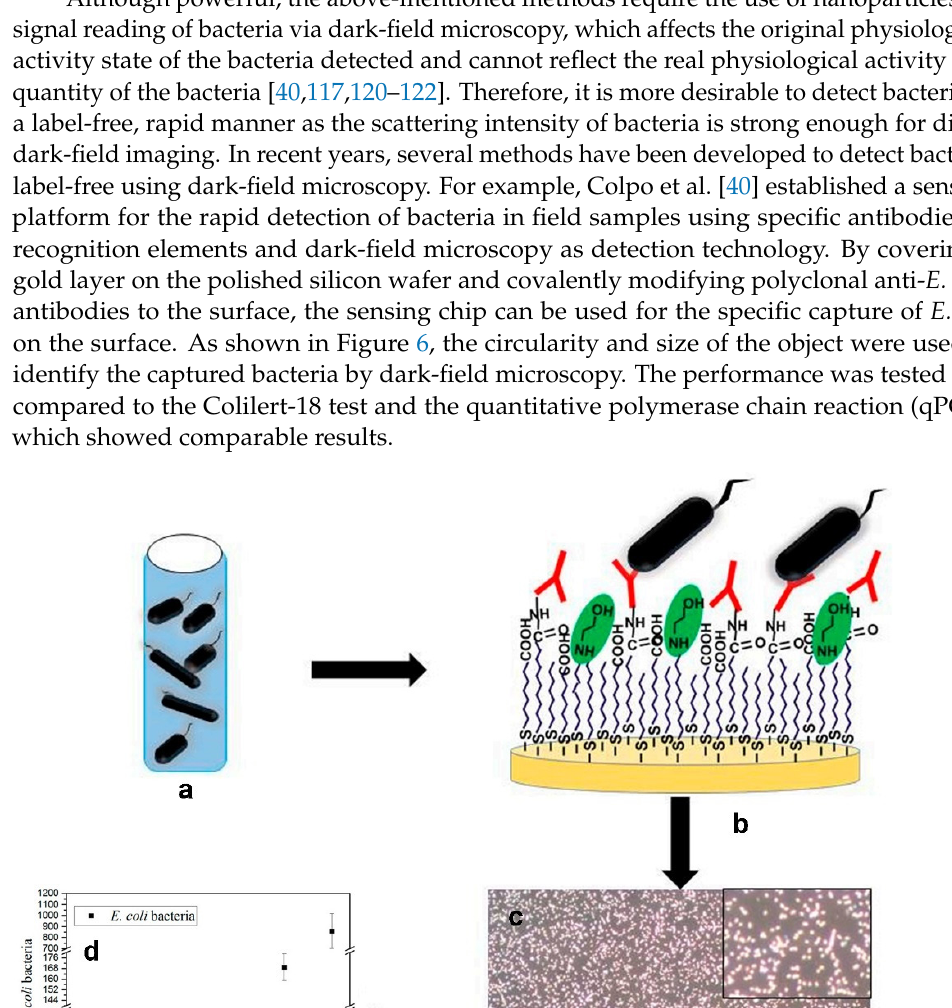
11 of 20 Figure 5. Schematic diagram of counting E. coli under dark-field, using antibody functionalization of MNP to form a gold ring structure around E. coli. ( a ) MNP probe was obtained by culture of E. coli antibody onto MNP. E. coli samples are first mixed with MNP probes to form probe- E. coli com- plexes. ( b )The complex of E. coli and MNP probes was separated by a magnet and then counted under a dark-field microscope. [119]. Adapted with permission from Ref. [119]. Copyright © 2018 The Author(s). Shiigi et al. [117] developed a novel molecular imprinting polymer (MIP) particle coated with gold nanoparticles (AuNPs) that can act as an acceptor and an optical signal